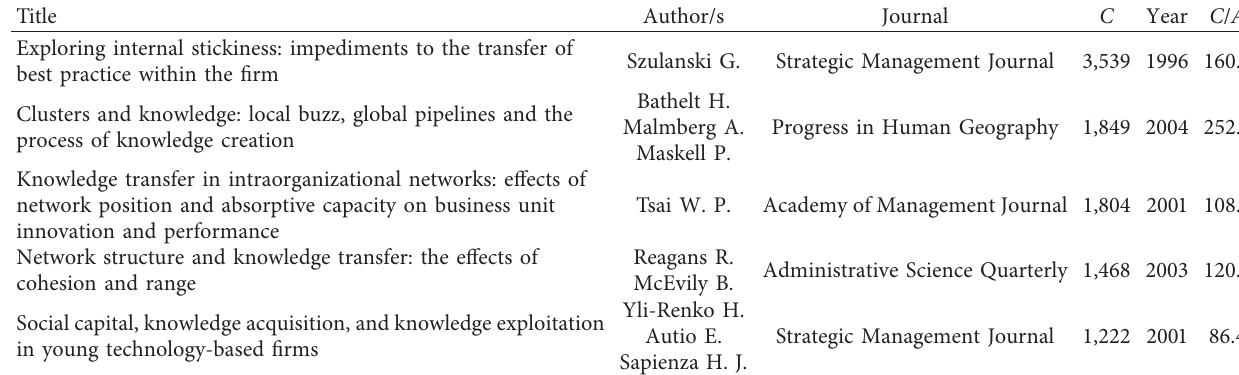
Table 4: The most cited articles.